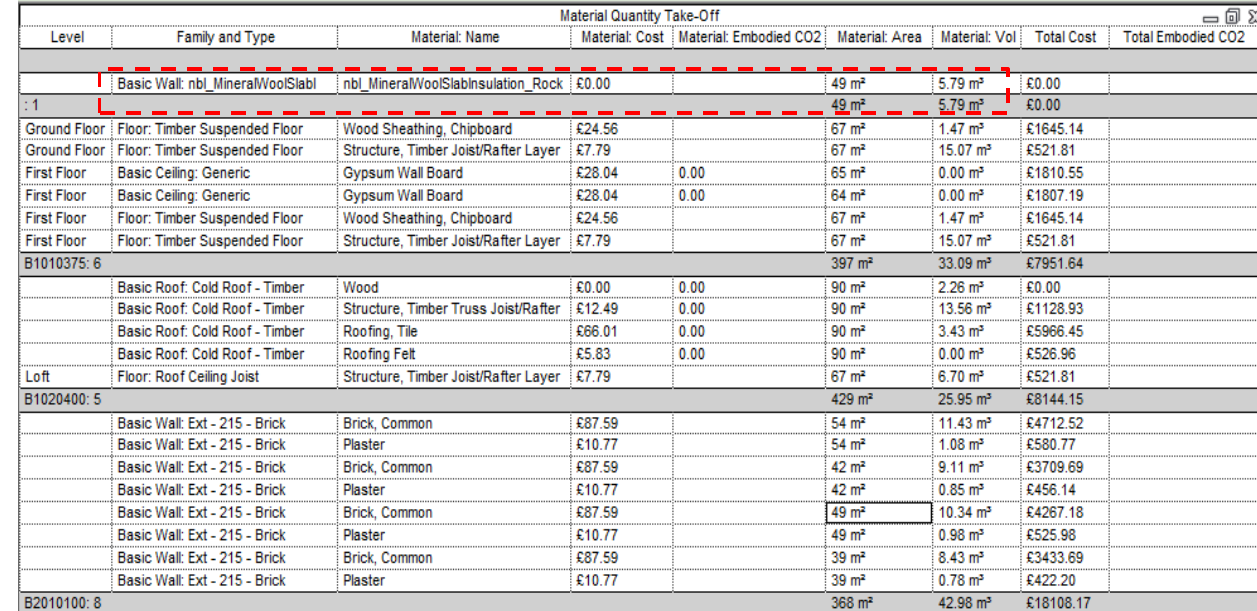
Figure 8. Material take-off function in BIM (Revit